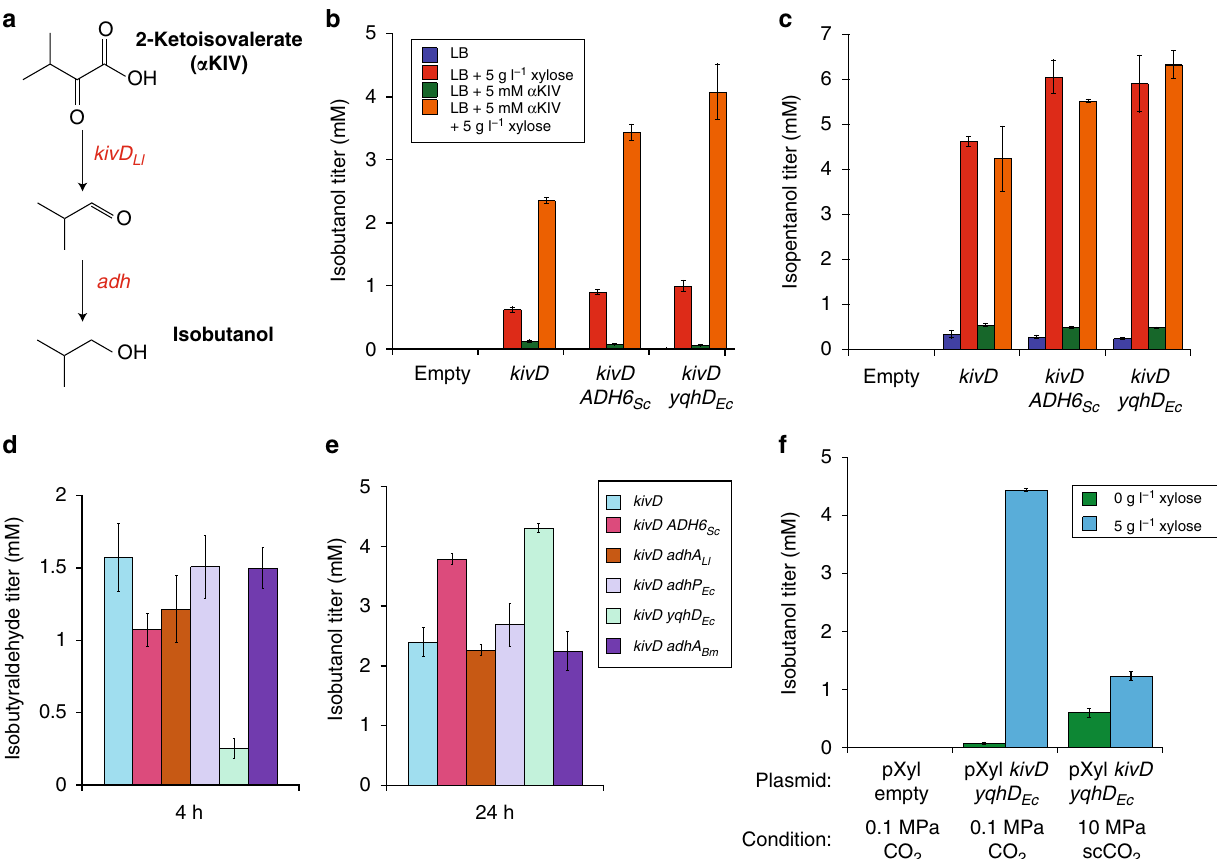
Fig. 4 Isobutanol and isopentanol production in SR7. a Two-step enzyme pathway to convert the valine intermediate 2-ketoisovalerate ( α KIV) to isobutanol using the decarboxylase enzyme KivD from L. lactis and an alcohol dehydrogenase. b Evaluation of isobutanol production at 24 h post induction in SR7 with an empty pXyl plasmid, pXyl kivD , pXyl kivD ADH6 Sc , or pXyl kivD yqhD Ec , where ADH6 and YqhD are alcohol dehydrogenases from S. cerevisiae and E. coli , respectively. Cultures were grown aerobically in LB medium in the presence and absence of 5 g l – 1 xylose as an inducer and 5 mM α KIV as substrate for the pathway. For all aerobic experiments, error bars represent the standard deviation of biological triplicate cultures. c Co-production of isopentanol measured in SR7 samples shown in b . d Accumulation of the isobutyraldehyde intermediate at short culture times, 4 h post induction. Alcohol dehydrogenases ADH6 from S. cerevisiae , AdhA from L. lactis , AdhP from E. coli , YqhD from E. coli , and AdhA from B. megaterium SR7 were evaluated to decrease the buildup of isobutyraldehyde intermediate for aerobic cultures fed 5 mM α KIV and induced with xylose. e Production of isobutanol at 24 h post induction for the cultures shown in d . f Production of isobutanol for SR7 cultures grown under 0.1 MPa CO 2 (biological triplicate cultures) and 10 MPa scCO 2 at 37 °C. Under scCO 2 , cultures with at least a tenfold increase in cell number, as enumerated by microscopy, were analyzed for alcohol production, sugar consumption and fermentation product generation. Average isobutanol titers from the aqueous phase of cultures showing at least 1 mM glucose consumption (classi fi ed as high activity; Supplementary Fig. 11) are provided. Source data are provided as a Source Data fi